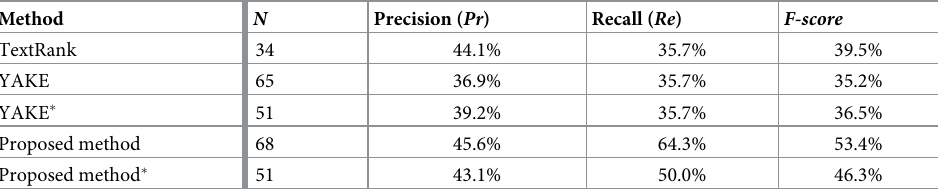
Table 5. Performance comparison of the proposed method with TextRank and YAKE.